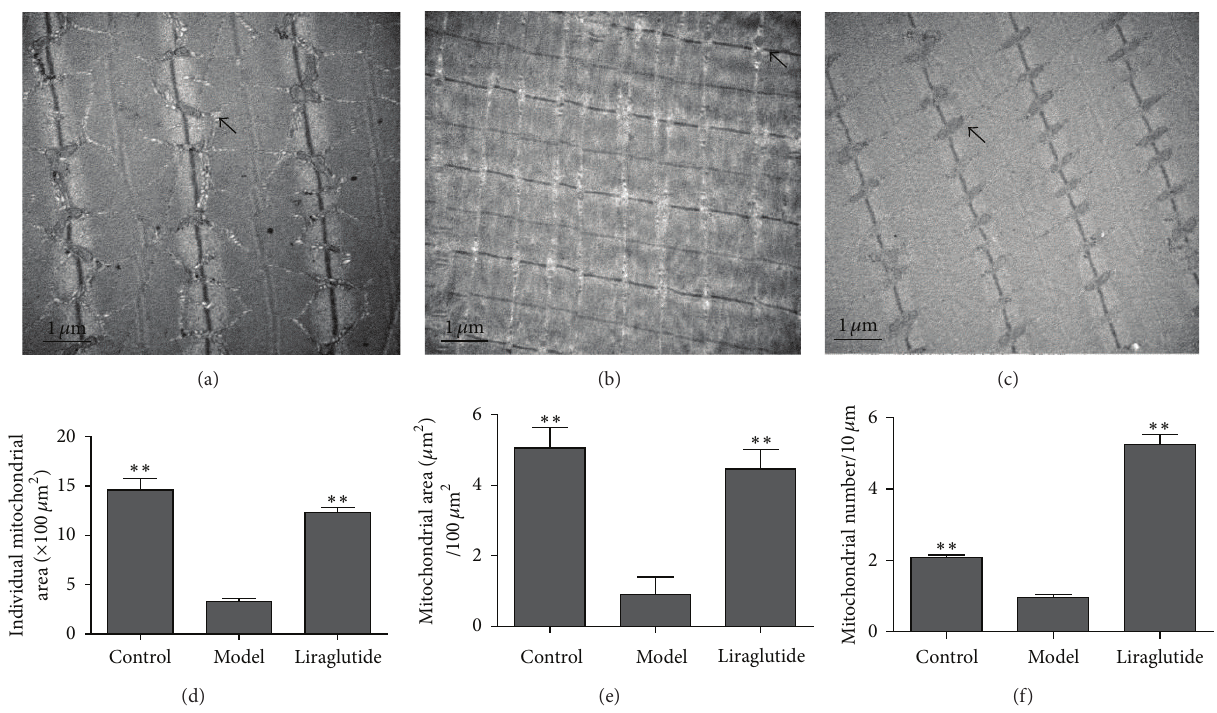
Figure 3: Individual mitochondrial area, mitochondrial area/100 𝜇 m 2 , and mitochondrial number/10 𝜇 m 2 in normal (a), model (b), or liraglutide group (c) measured by the electron microscope. Individual mitochondrial area (d), mitochondrial area/100 𝜇 m 2 (e), and mitochondrial number/10 𝜇 m 2 (f) in skeletal muscle were significantly increased when compared with diabetic mice (data were shown as mean ± SEM, ∗∗ 𝑃 < 0.01 versus model